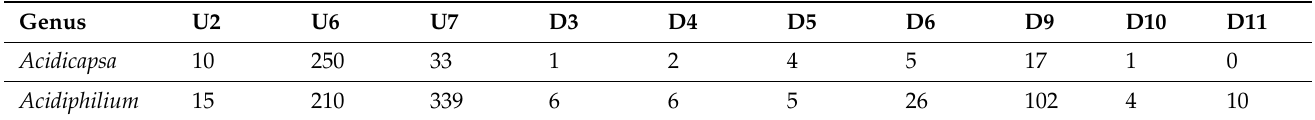
Table 10. Greatest bacterial abundance by genus for the Zone B, D and E upstream sites (U2, U6, U7). These sample sites were dominated by acidophilic species (and a low pH).